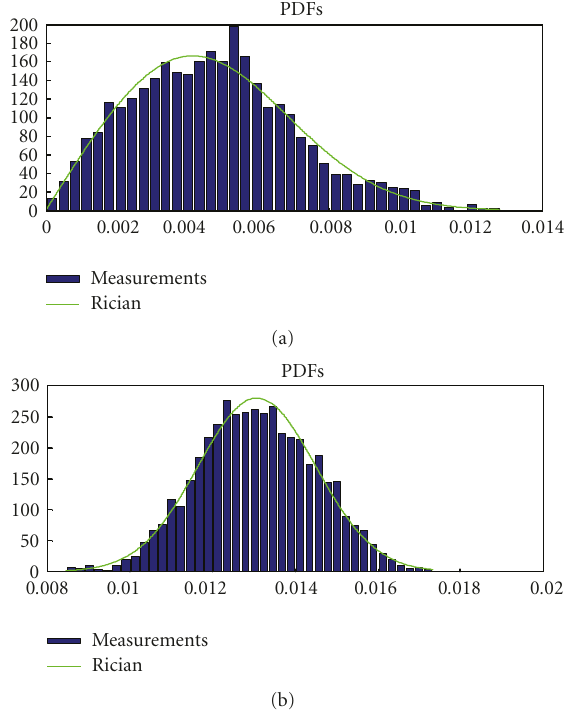
Figure 8: PDFs of the field amplitude in a transverse plane either deduced from measurements or calculated assuming a Rice distribution: (a) d = 50 m and f = 5GHz, (b) d = 500m and f =